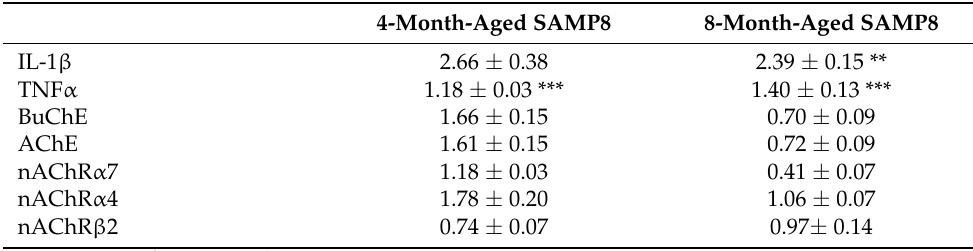
Table 5. Gene expression (2 − ∆∆ Ct ) of IL-1 β , TNF α , BuChE, AChE, nAChR α 7, nAChR α 4 and nAChR β 2 in the brain of 4- and 8-month-aged SAMP8 mice in relation to the brain samples from the age-matched SAMR1 mice.